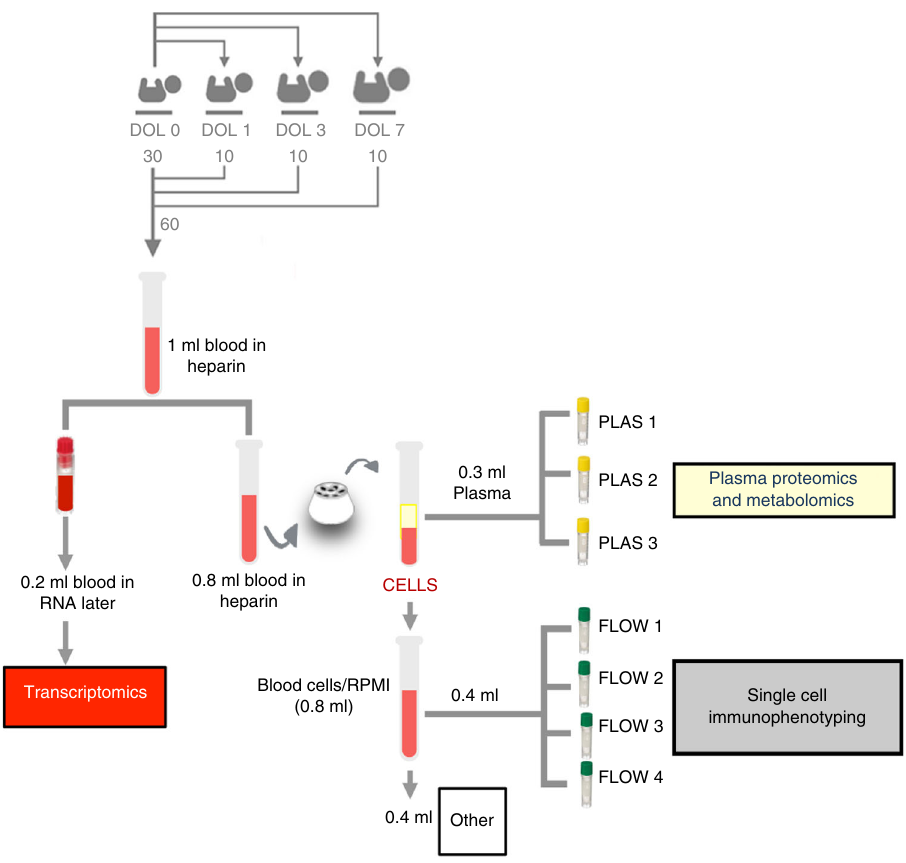
Fig. 1 Sample processing overview. Thirty newborns were recruited in The Gambia, with each newborn providing a peripheral blood sample on DOL0 and subsets of ten newborns each providing a second peripheral blood sample at either DOL1, 3 or 7, resulting in a total of 60 blood samples. Newborn peripheral venous blood was drawn directly into heparinized collection tubes. Aliquots (200 μ l) were removed for transcriptomic analysis. Plasma was then harvested from the remaining whole blood after a spin, and cryopreserved for cytokine, proteomic and metabolomic analyses. The remaining cellular fraction was diluted with phosphate-buffered saline (PBS) to replace the volume of plasma removed, and 100 μ l aliquots from this mixture were processed for single-cell immunophenotyping by fl ow cytometry. With a starting volume of 1 ml, this standard operating protocol still left the cellular fraction contained in 400 µ l of starting blood volume that could be used for other analyses. DOL: day of